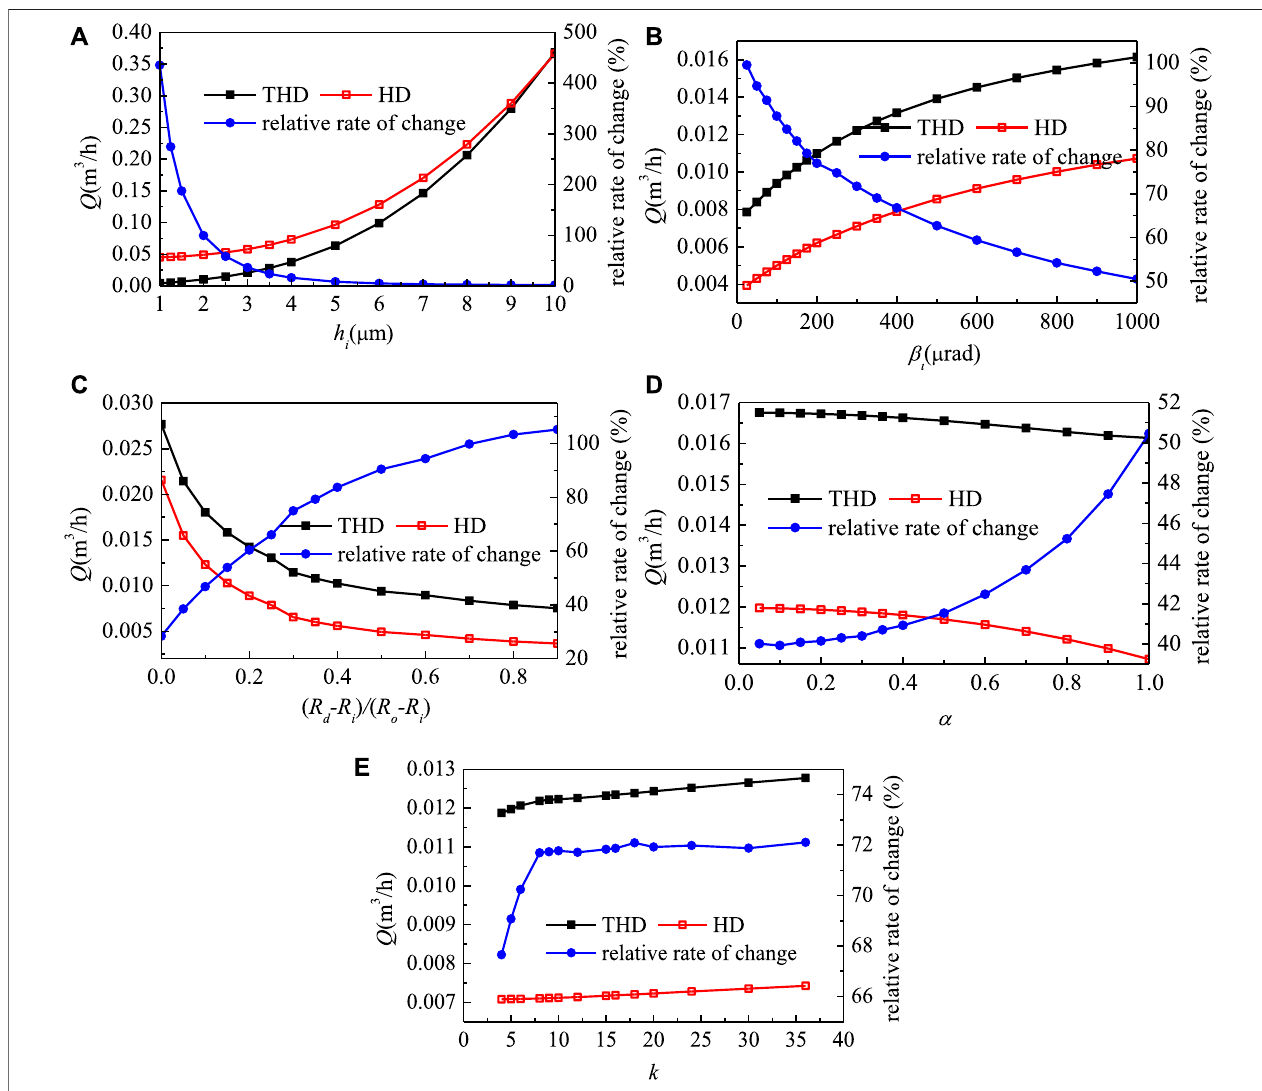
FIGURE 4 | In fl uence of structural parameters under the viscosity-temperature effect on leakage.